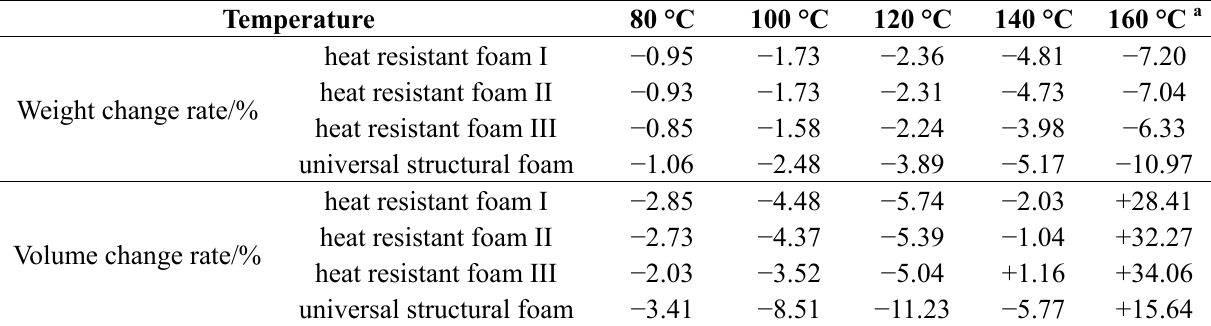
Table 3. Dimension stability of foam